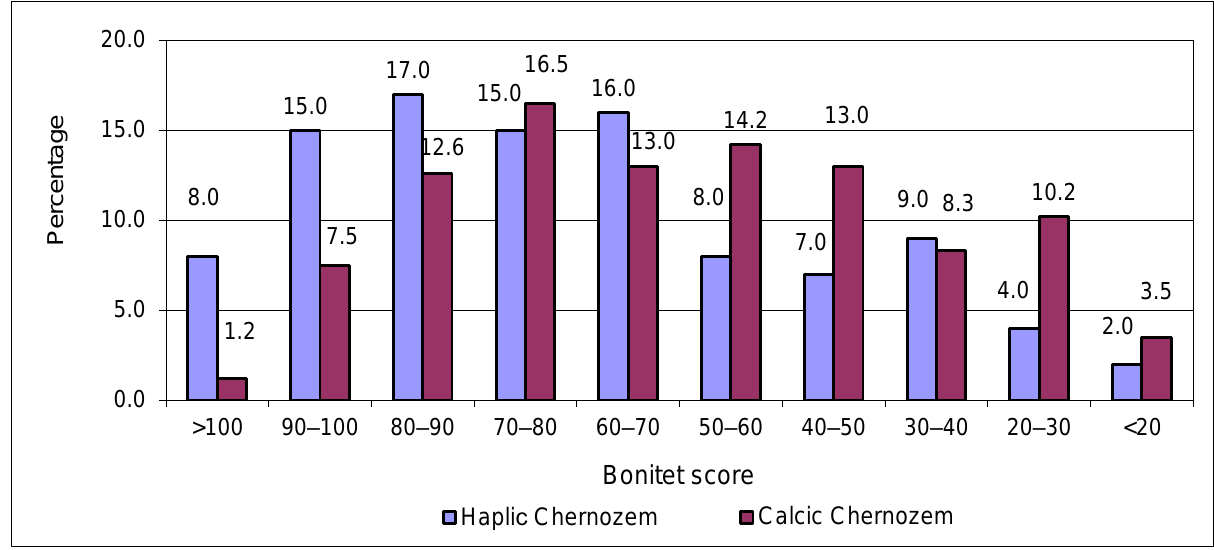
Figure 2. Quality ranking of Chernozem.